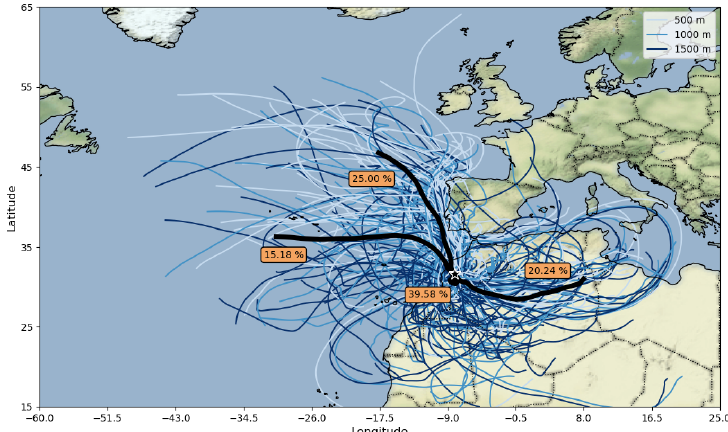
Figure 10. HYSPLIT climatological modelling showing the trajectories of aerosols located over Saada during summer from 2005 to 2020 for lower heights (0.5, 1 and 1.5 km). The Saada location is marked with a black star. The black lines correspond to the trajectories obtained via cluster analysis and the percentages represent the ratio of trajectories used for the computation.